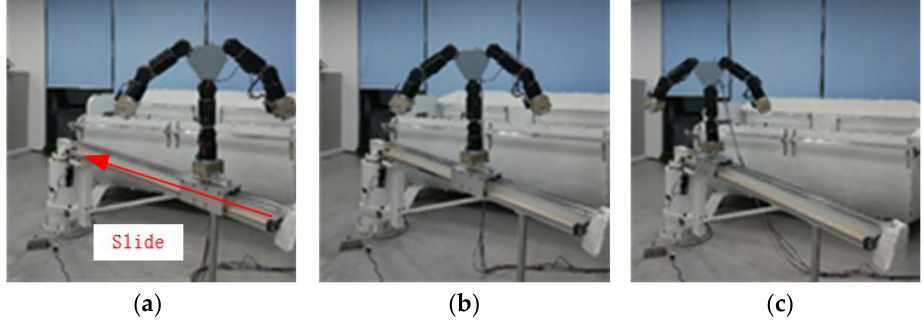
Figure 14. Sliding Mode. ( a ) Motion start; ( b ) In the process of motion; ( c ) Motion complete.